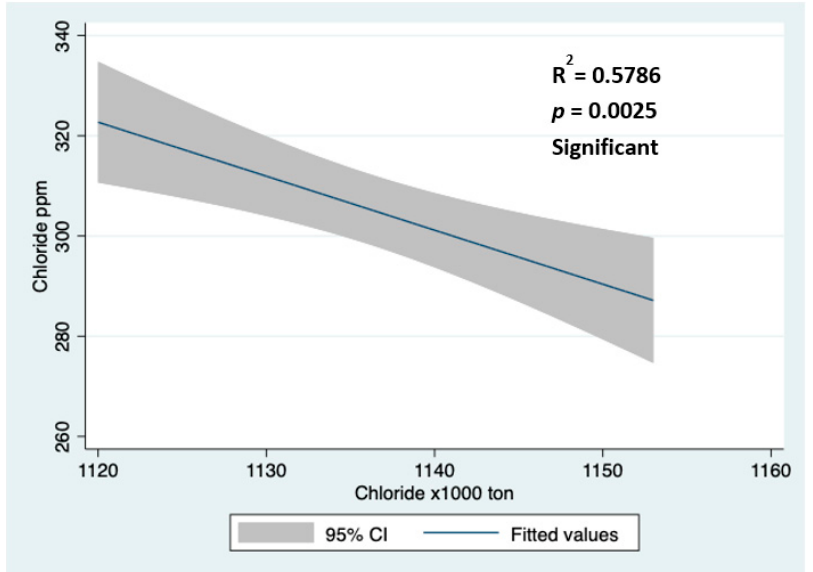
load was enhanced by 36,000 tons, although a pump of 136.2 mcm pelagic lake water was removed [2].